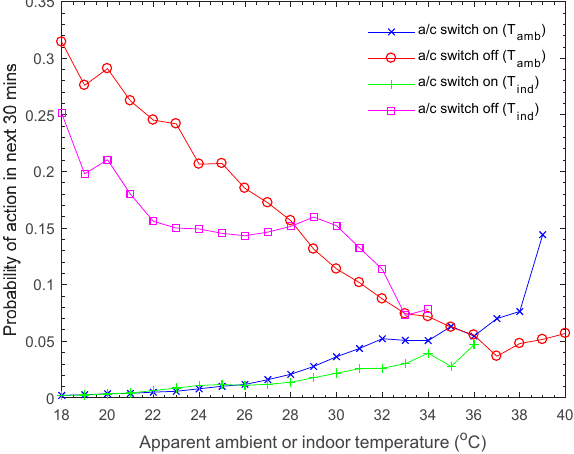
Figure 4. Probability of air-conditioner (a/c) “switch on” action and “switch off” actions as a function of apparent ambient and apparent indoor temperatures for days.